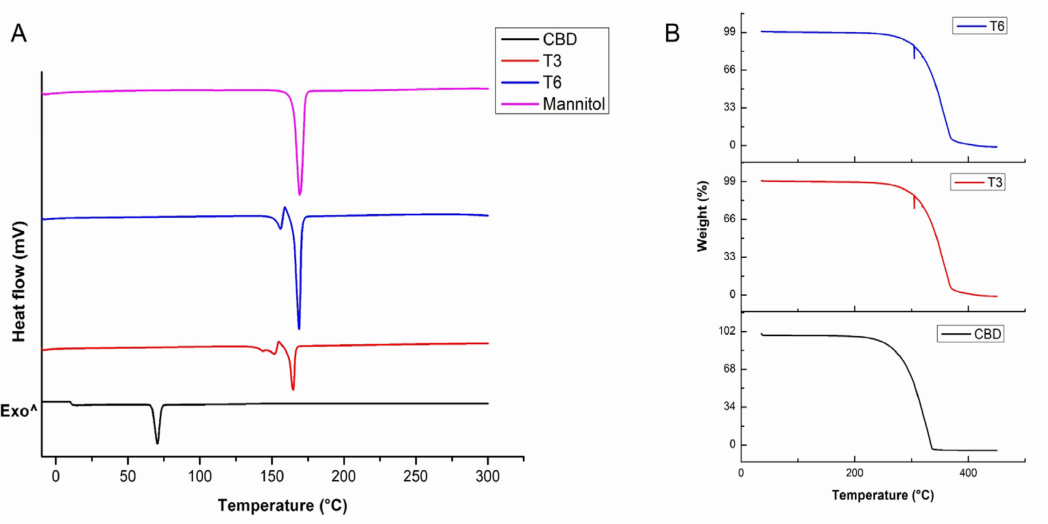
Figure 3. ( A ) DSC thermogram and ( B ) TGA thermogram of pure CBD, transfersomes (T3) and CBD-loaded transfersomes (T6)